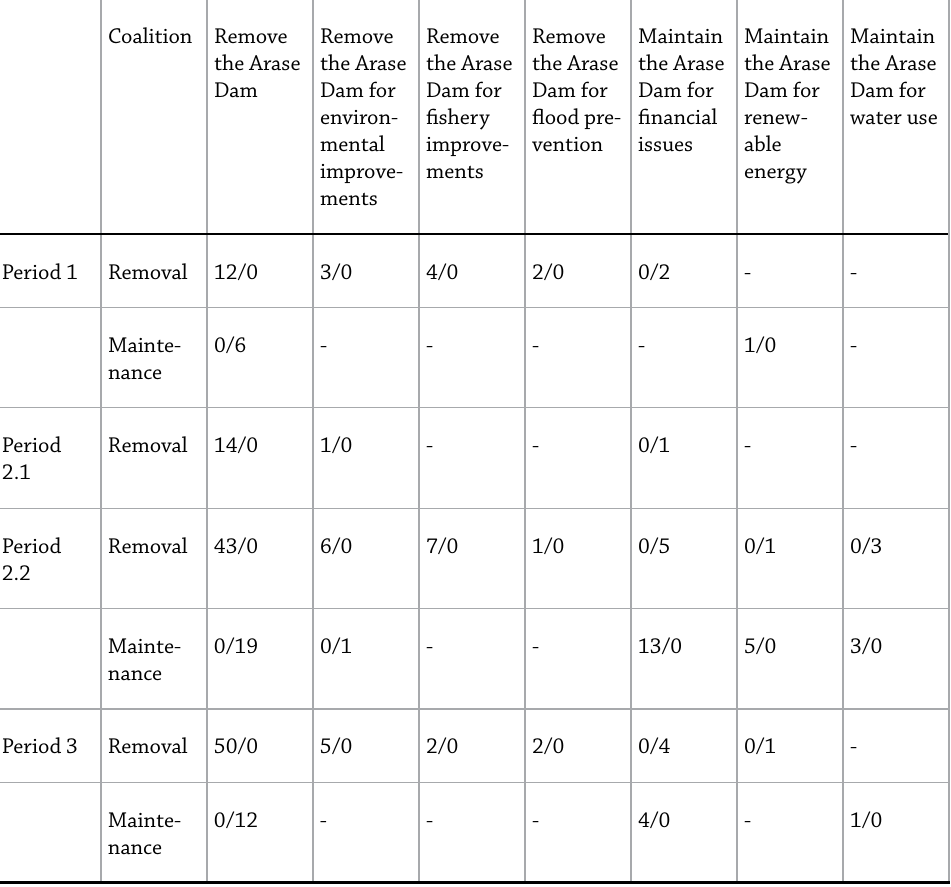
Table 3. Changes in policy beliefs in each coalition Coalition